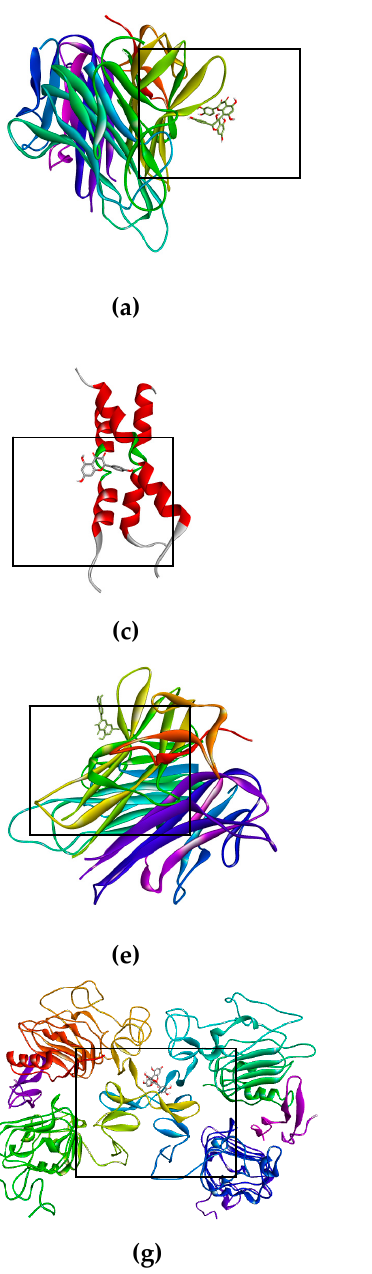
Figure 3. Binds of biflavonoid, kaempferol and quercetin with death receptor. The box indicates the binding region. ( a ) Biflavonoid binds to TNF-R1, ( b ) Biflavonoid binds to DR4, ( c ) Kaempferol binds to Fas/CD95, ( d ) Kaempferol binds to DR5 ( e ) Quercetin binds to TNF-R1, ( f ) Quercetin binds to DR4, ( g ) Biflavonoid binds to EGFR, and ( h ) Biflavonoid binds to K-Ras.